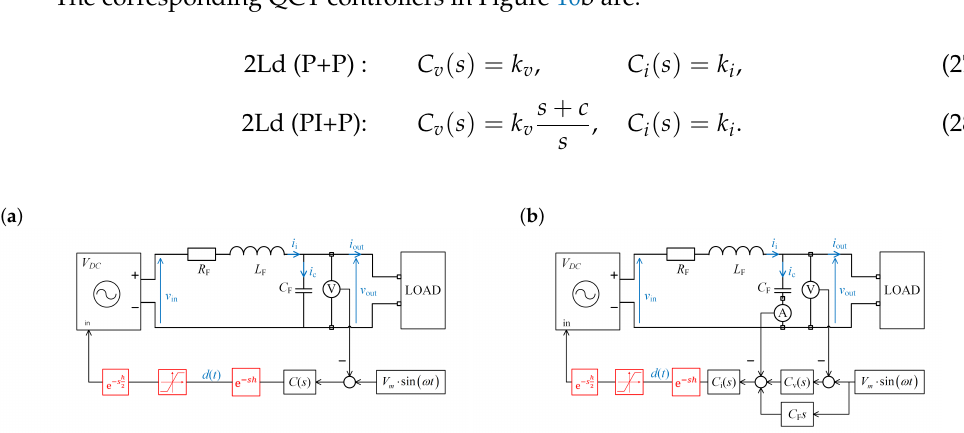
Figure 10. Schematic diagrams of QCT models for digital control systems depicted in Figure 3a: ( a ) 1Ld-single loop and ( b ) 2Ld-double-loop with the capacitor current